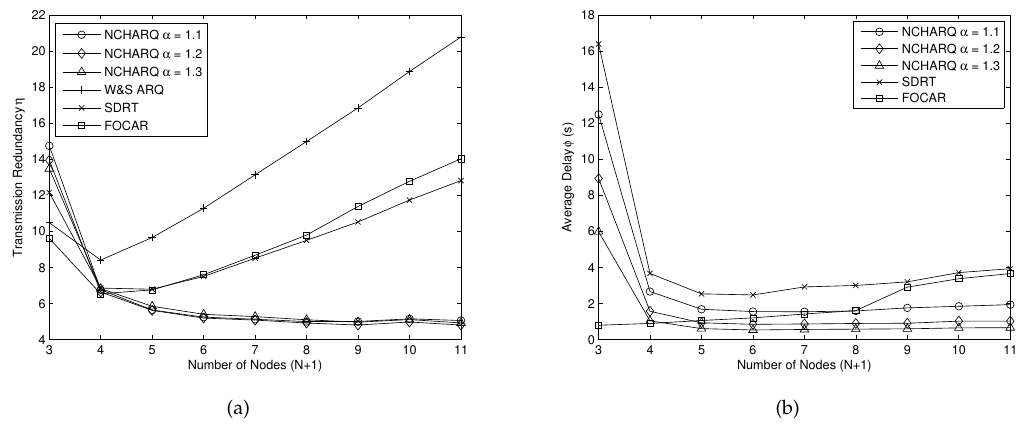
Figure 8. ( a ) the transmission redundancy η for different protocols; ( b ) the average delay φ for different